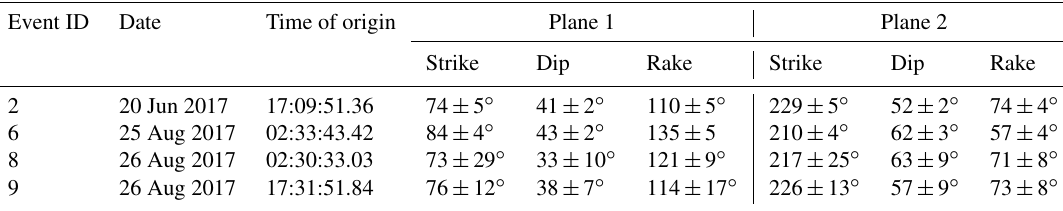
Table 2. Fault plane solution for events 2, 6, 8 and